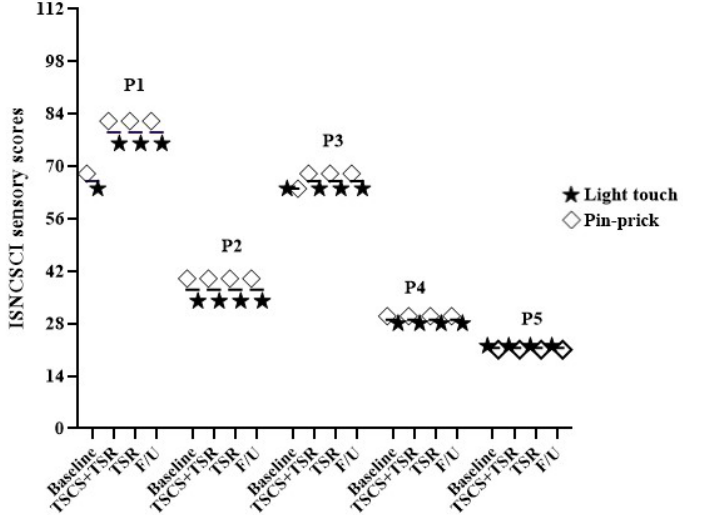
Figure 8. The International Standards for Neurological Classification of Spinal Cord Injury (ISNCSCI) scores with light touch and pinprick sensory sub-scores obtained in this study.